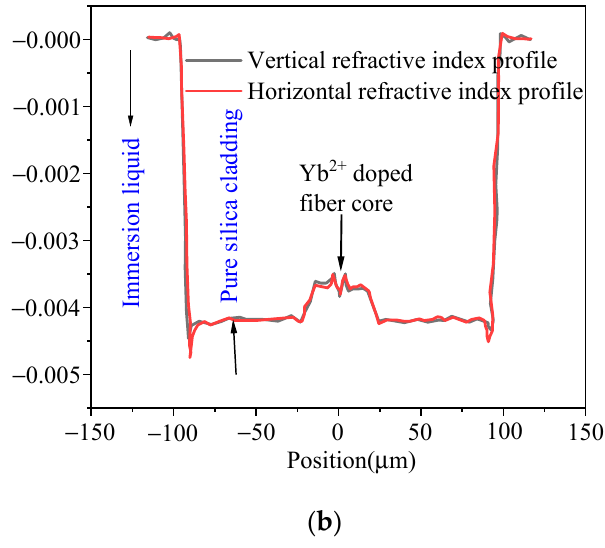
Figure 7. ( a ) Typical scanning electron microscopy image (scale bar of 30 μ m) and ( b ) refractive index profile of the Yb 2+ -doped fiber.